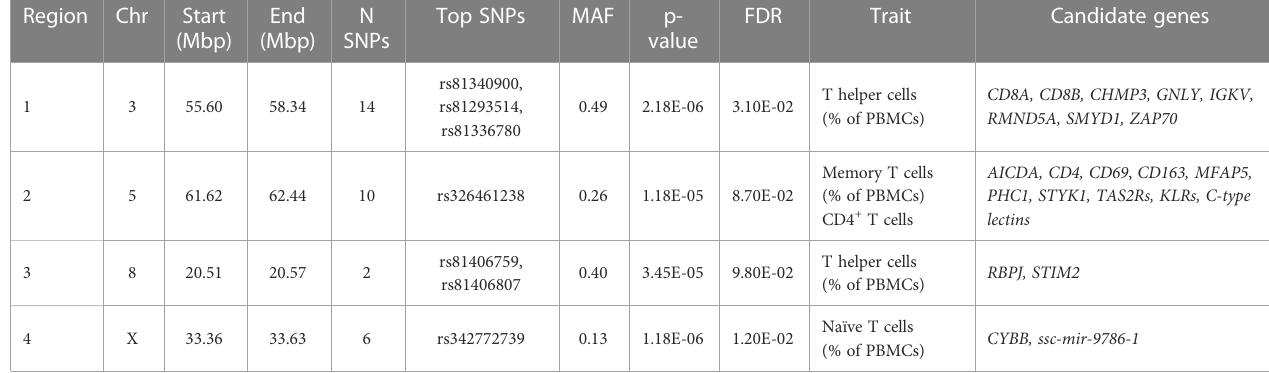
TABLE 3 Description of the four chromosomal regions associated with cell immunity traits and the annotated candidate genes.